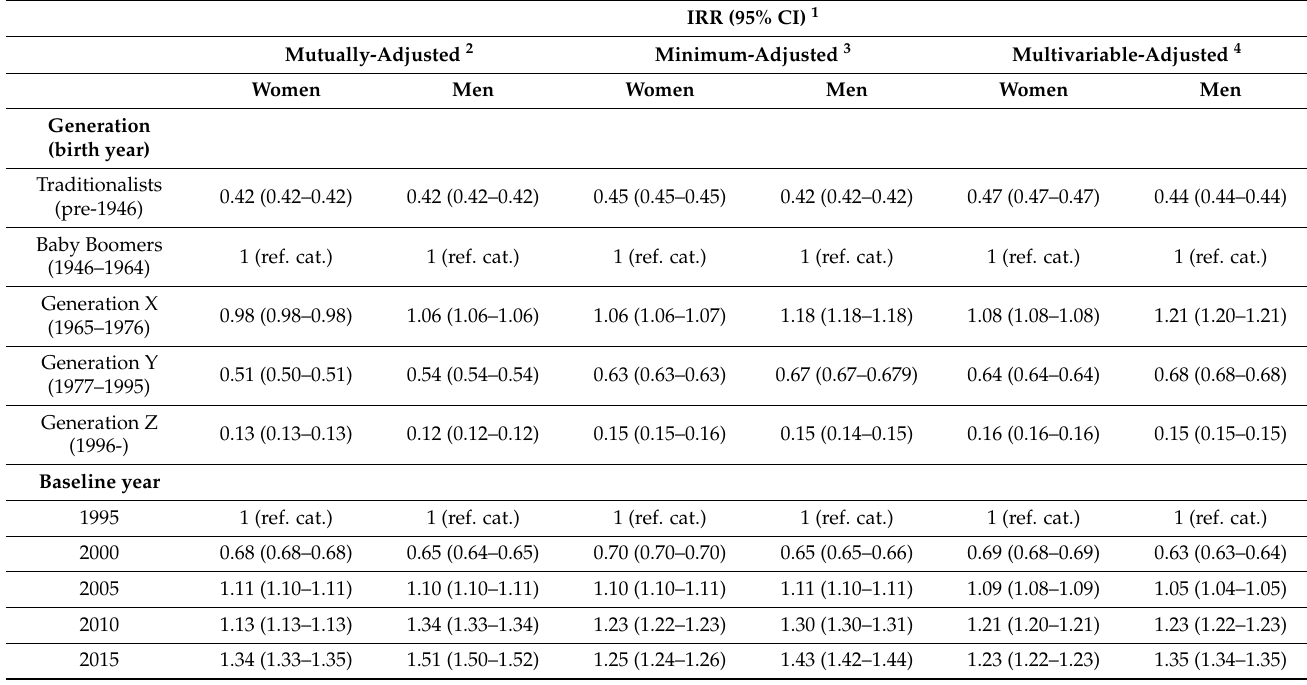
Table 3. Associations of generation and baseline year with years in paid work, among women and men aged 19–69 in Sweden in